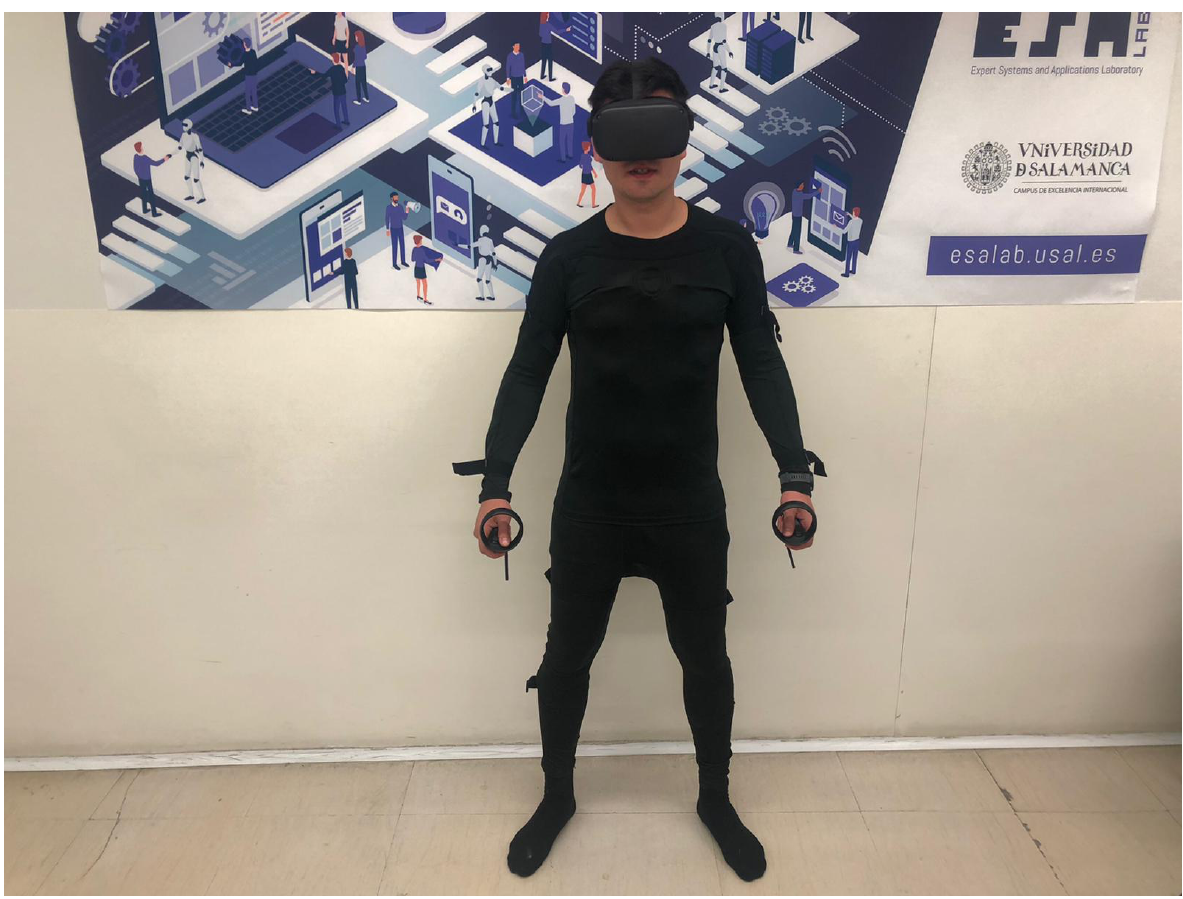
Figure 10. User with Oculus and Enflux